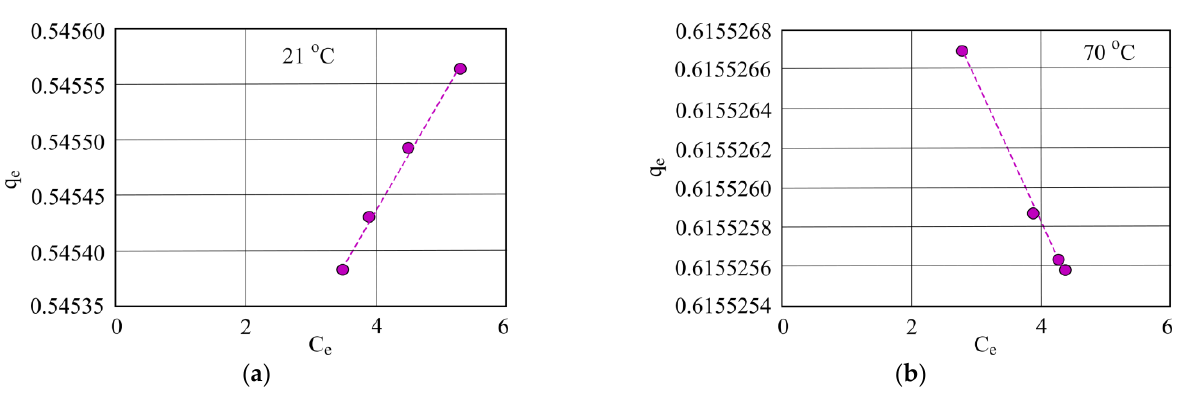
Figure 13. Freundlich isotherm when investigated water is at ( a ) 21 °C and ( b ) 70 °C using granulated mineral sorbent.